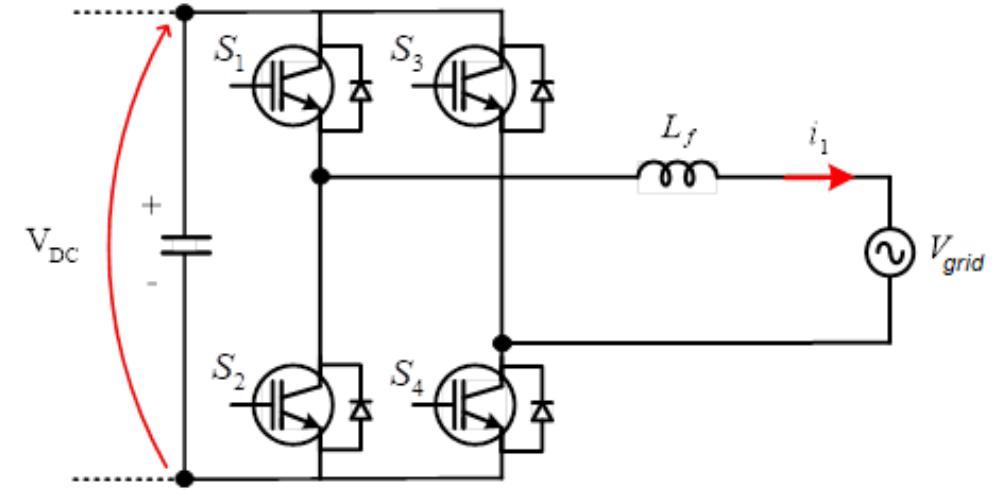
Figure 1. Single-phase VSI with the L filter.